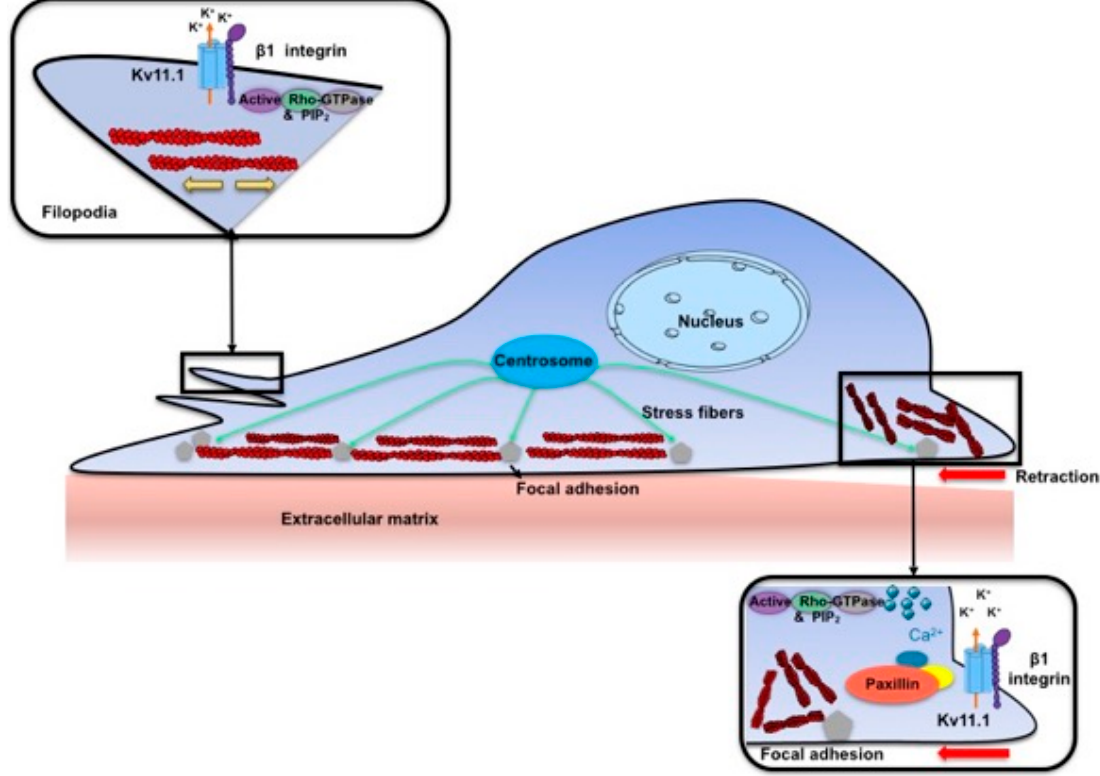
Figure 9. Proposed mechanism for the modulation of f-actin organization exerted by K V 11.1 channels during cell migration of pancreatic ductal adenocarcinoma cells. The migratory machinery is a complex unit in pancreatic ductal adenocarcinoma (PDAC) cells and it is represented by the centrosome which directs focal adhesion and actin rearrangement. We propose that K V 11.1 channels are essential to maintain stress fibers in a less organized format (as represented on the upper left side inset) in PANC-1 filopodia, while in focal adhesion (right lower panel) K V .11.1 complexes with β 1 integrin modulating downstream signaling molecules, such as paxillin, impacting on actin organization which results to be more disorganized. We propose that this is a Ca 2+ dependent mechanism.